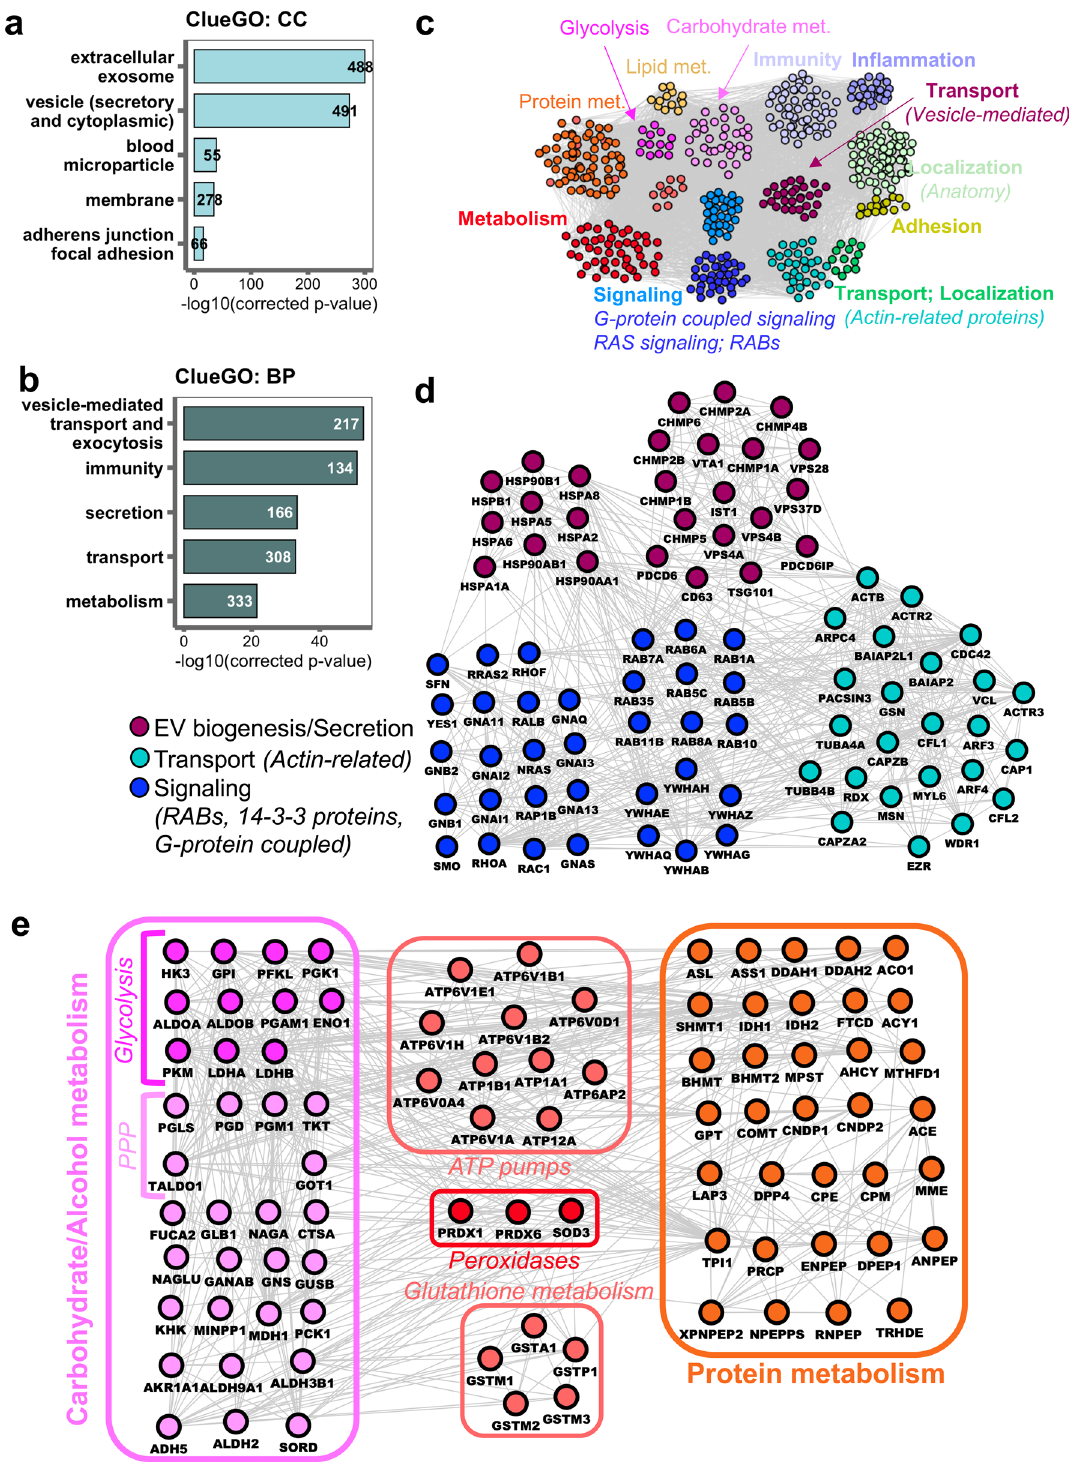
Figure 3. Enriched biological functions in the core urinary EV proteome. ( a ) Gene ontology (GO) term cellular component (CC) analysis of the core urinary EV proteome. Barplots show top 5 GO:CC terms associated with the core urinary EV proteome, analyzed using ClueGO 28 . ( b ) Gene ontology (GO) term biological process (BP) analysis of the core urinary EV proteome. Barplots show top 5 GO:BP terms associated with the core urinary EV proteome, analyzed using ClueGO 28 . ( c ) Schematic overview of the enriched biological functions in the core urinary EV protein network (516 proteins), analyzed by clusterONE 31 and BINGO 32 . For the detailed network, see Supplementary Fig. 4. ( d ) Protein interaction network of EV markers and associated signaling and localization protein clusters, predicted by clusterONE 31 . ( e ) Protein interaction network of metabolic cluster. Enriched sub-networks predicted by clusterONE 31 are indicated within the figure. PPP: Pentose-Phosphate Pathway